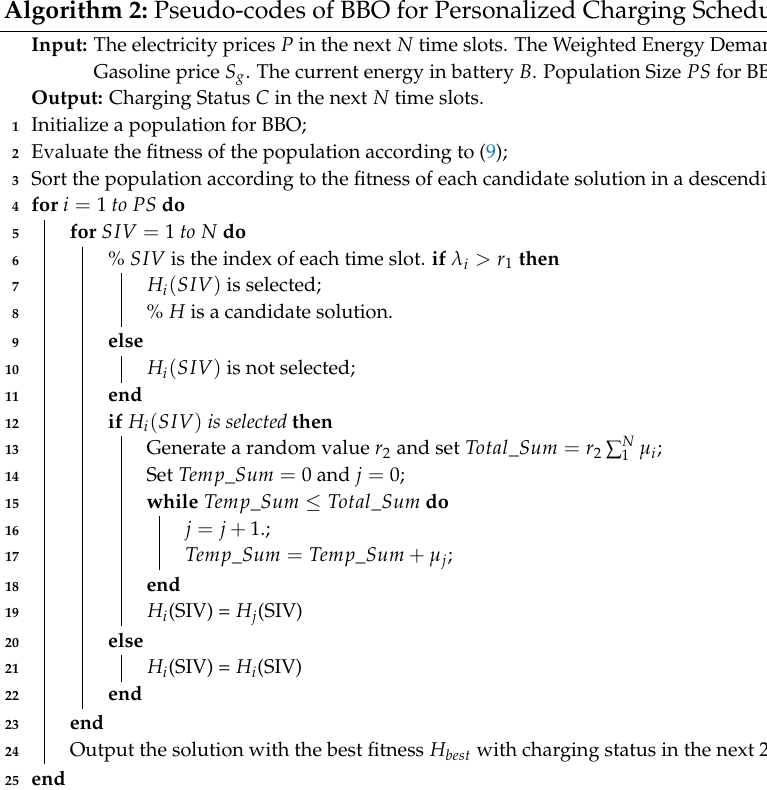
Algorithm 2: Pseudo-codes of BBO for Personalized Charging